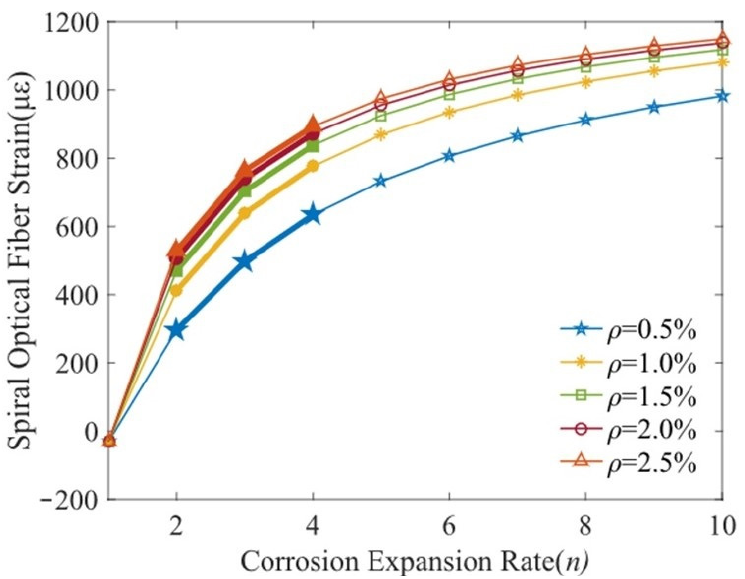
Figure 7. Fiber strain versus corrosion expansion coefficient.